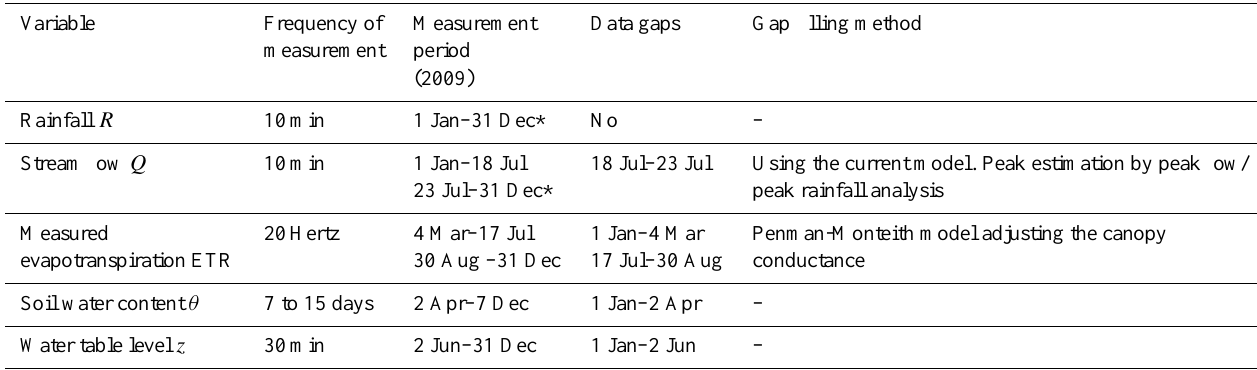
Table 1. Measured hydrologic variables, record and gaps periods.